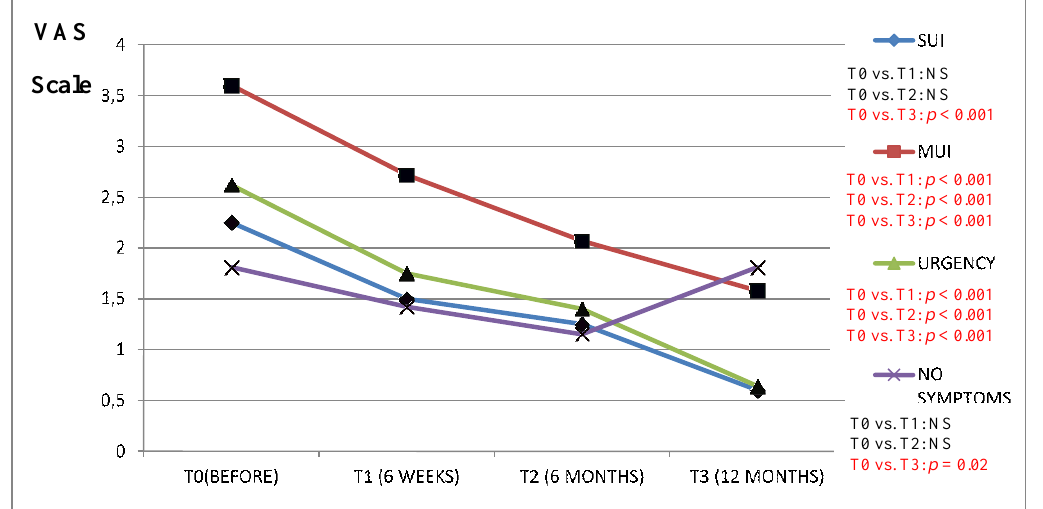
Figure 3. Impact of the vaginal native tissue repair (VNTR) on stool and gas incontinence—according to the visual analogue scale (VAS).